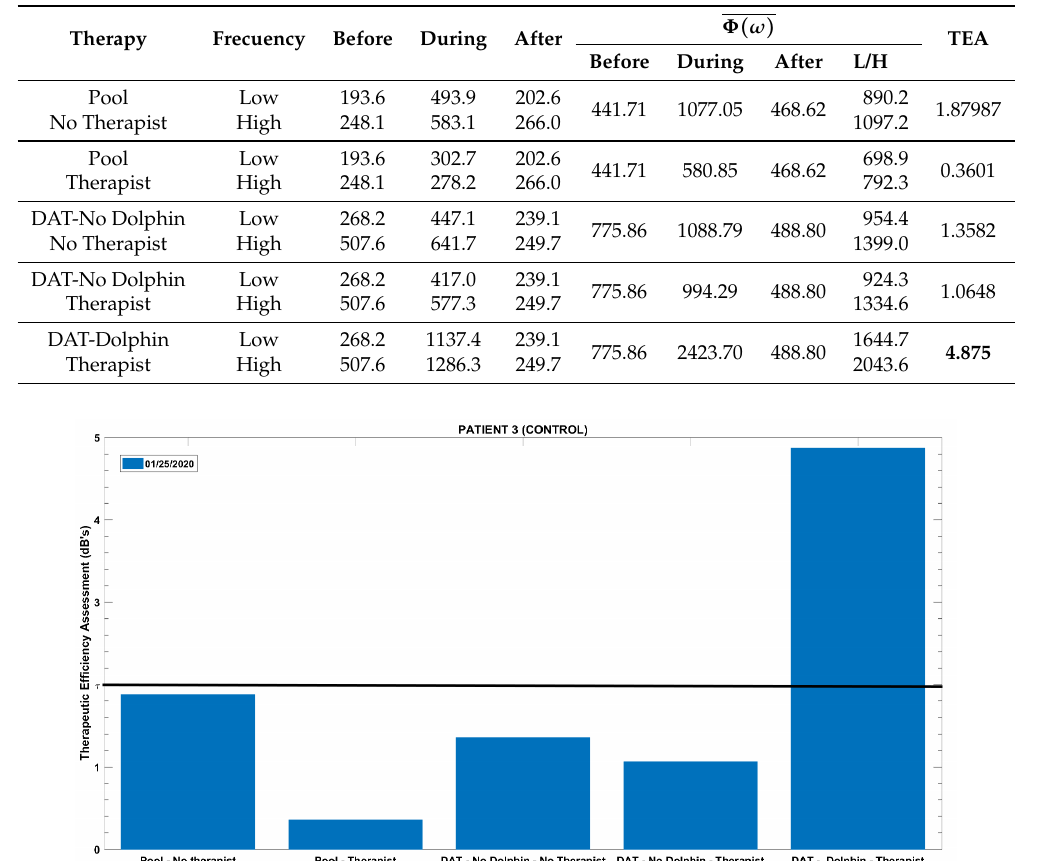
Figure 21. Results of the Patient 3 (Control), On 01/25/2020. Continuous line indicates an efficiency threshold of ± 2 dB of